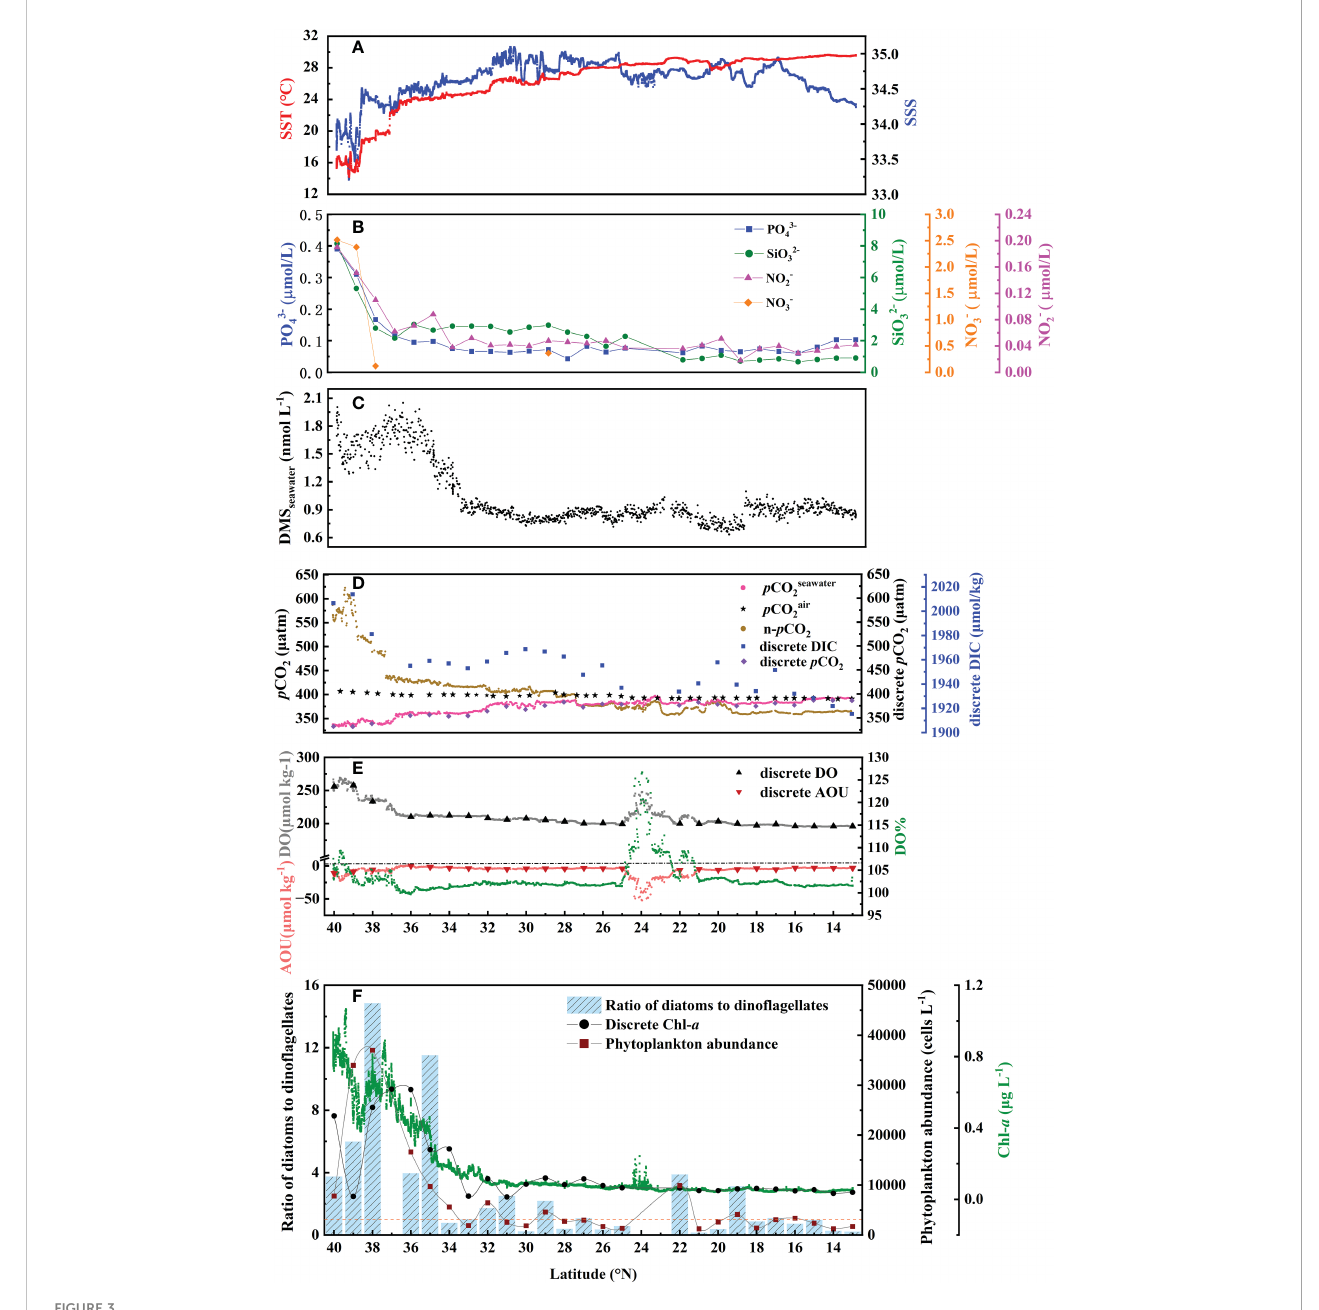
FIGURE 3 Latitudinal change along the 150°E transect in November 2019 in (A) underway SST and SSS, (B) discreate PO 3- 4 , SIO 2- 3 , NO (cid:4) 2 , and NO (cid:4) 3 , (C) underway DMS seawater , (D) underway p CO seawater 2 , p CO air 2 , and n- p CO 2 ; discreate DIC and p CO 2 , (E) underway DO, AOU and DO%; discreate DO and AOU, and (F) underway Chl- a , discreate Chl- a , ratio of diatoms to dino fl agellates, and phytoplankton abundance. Samples for discrete parameters were collected at each